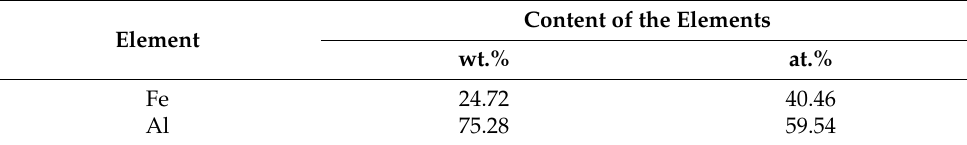
Figure 11. Typical FeAl solid solution microstructure on the cross-section of the FeAl VIGA powder particle ( a ), and SEM/EDX spectrum corresponding to the EDX area analysis ( b ). Table 6. Chemical composition of FeAl VIGA powder particles.